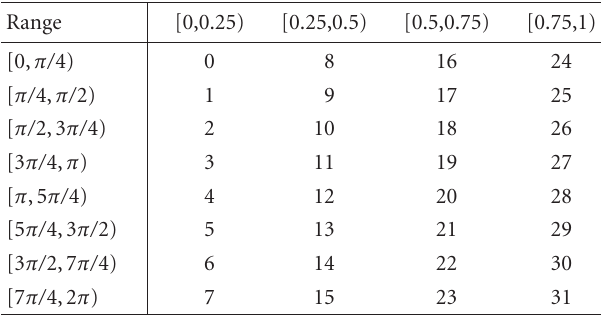
Table 1: Mapping from gradient field of intensity image to GCM ( Δ ρ = 1 / 4, Δ θ = π/ 4).